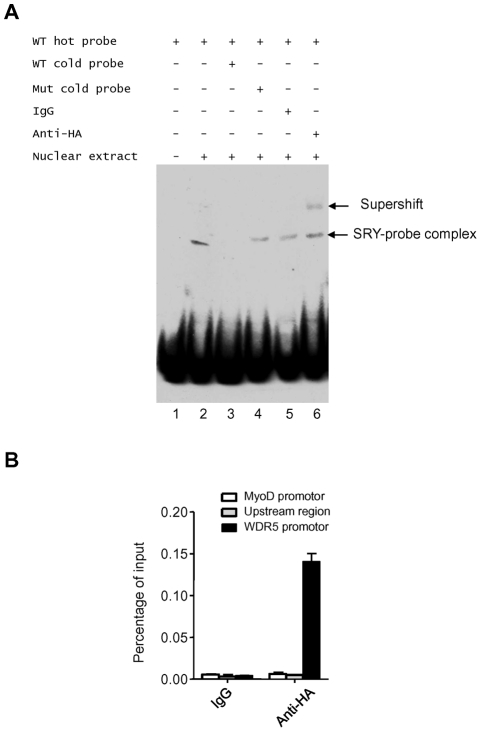
SRY binds to WDR5 promoter.(A) EMSA analysis of HA tagged SRY with wild type and mutant probes. Arrows indicate SRY-probe complex and supershift. (B) ChIP analysis of HA tagged SRY on WDR5 promoter,WDR5 promoter proximal upstream region, or MyoD promoter. Mouse IgG serves as a negative control. Graphs show mean ± SD, n = 3.